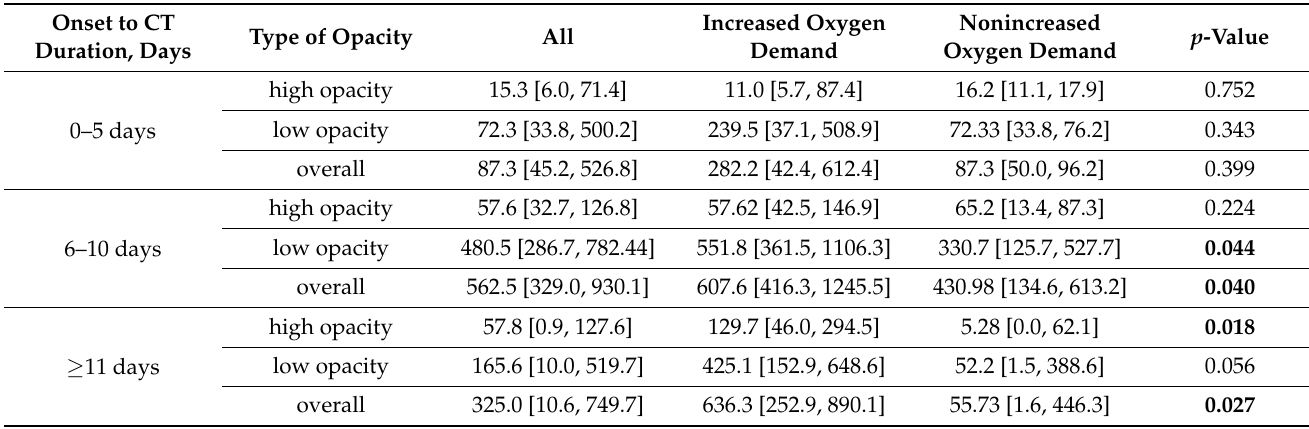
Table 2. Volume of opacities in increased oxygen demand group and nonincreased oxygen demand group stratified by time from onset to CT scan.